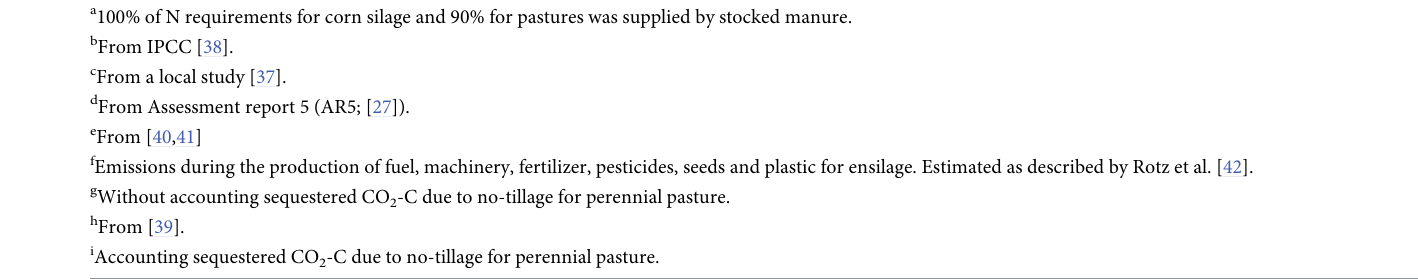
a function of the time at pasture. The biodegradability of manure factor (0.13 for dairy cows in Latin America) and methane conversion factor (MCF) values were taken from IPCC [38]. The MCF values for pit storage below animal confinements ( > 1 month) were used for the calcula- tion, taking into account the annual average temperature (16.6 º C) or the average temperatures during the growth period of temperate (14.4 º C) or tropical (21 º C) annual pastures, which were 31%, 26% and 46%, respectively. The N O-N emissions from urine and feces were estimated considering the proportion of 2 N excreted as manure and storage or as urine and dung deposited by grazing animals. These proportions were calculated based on the proportion of daily time that animals stayed on pas- ture (7 h/24 h = 0.29) or confinement (1 − 0.29 = 0.71). For lactating heifers and cows, the total